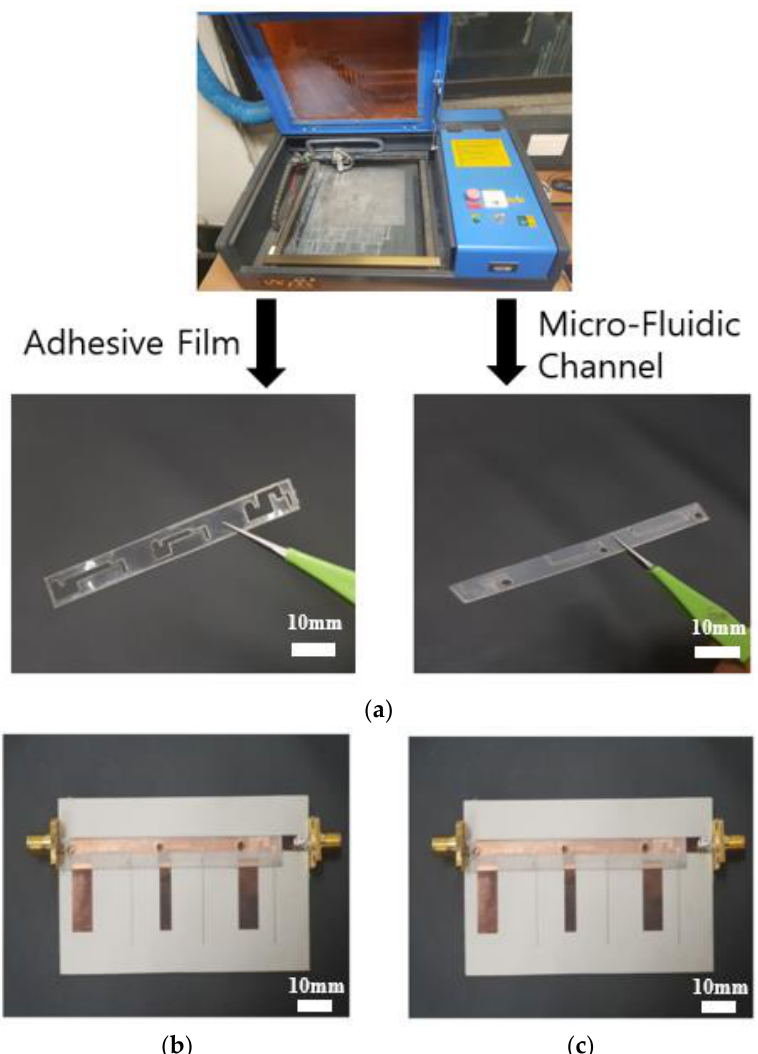
Figure 4. ( a ) The process of fabricating the fluidic channel and adhesive film using a laser cutting machine. The picture of the fabricated proposed filter ( b ) is shown without the microfluidic channel; ( c ) is shown with the added microfluidic channel.